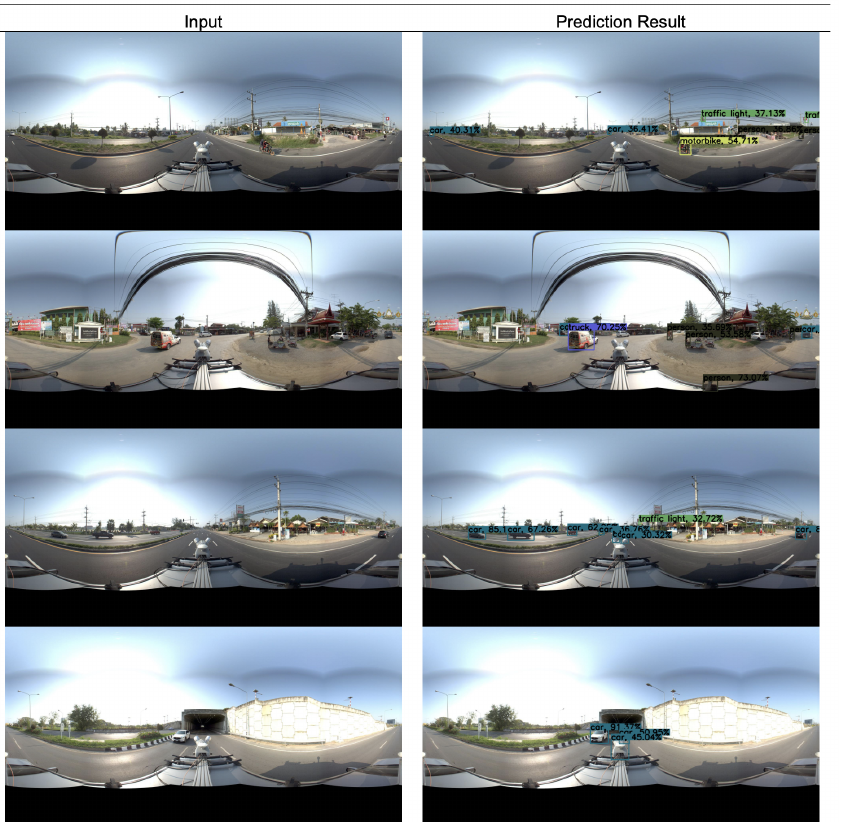
Figure 9. Visualized detection results of YOLOX-Transformer with FPN on Pascal VOC data